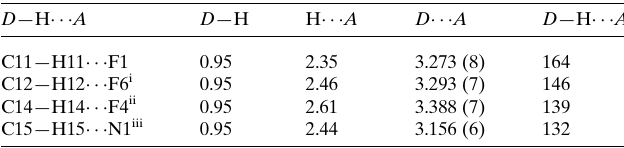
Table 1 Hydrogen-bond geometry (A˚ , (cid:2) ).